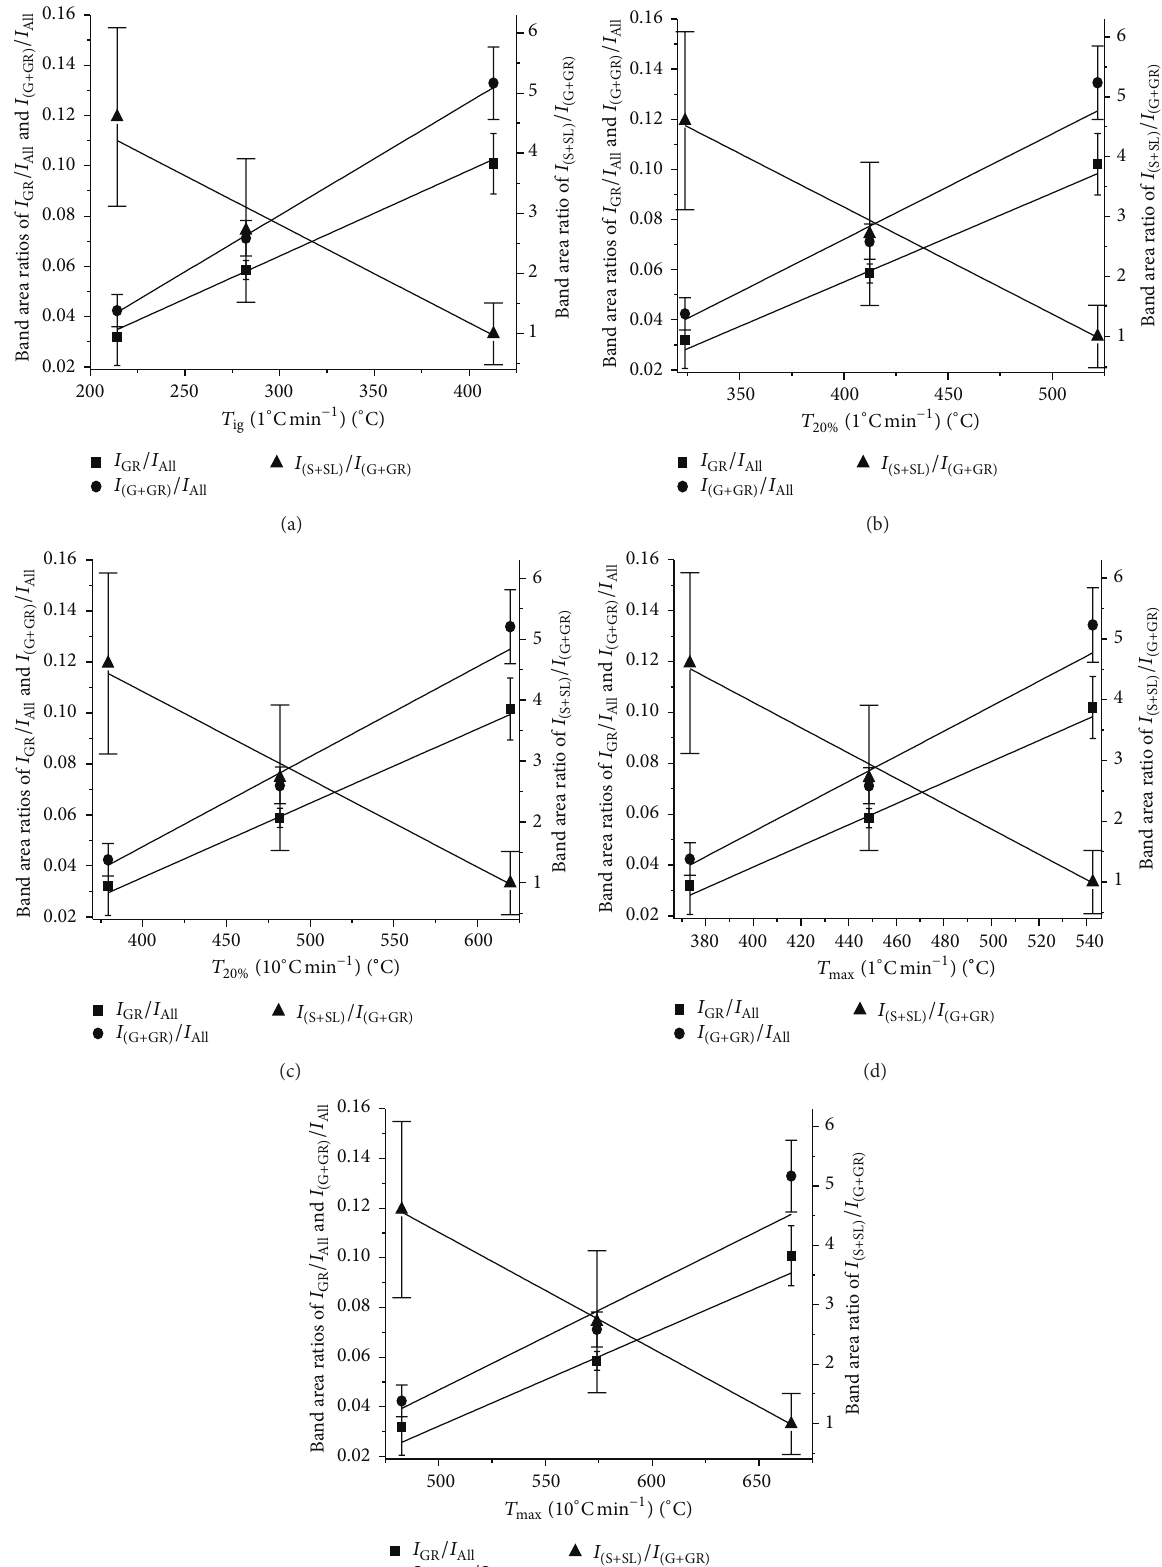
/𝐼 /𝐼 /𝐼 , 𝐼 ( ,and 𝐼 ( ( G + GR ) ,correlatedwithcoalreactivityindexes:(a) GR All G + GR ) All S + SL ) (1 ∘ Cmin −1 ), and (e) 𝑇 (10 ∘ Cmin −1 ), respectively. The error bars show the standard max max